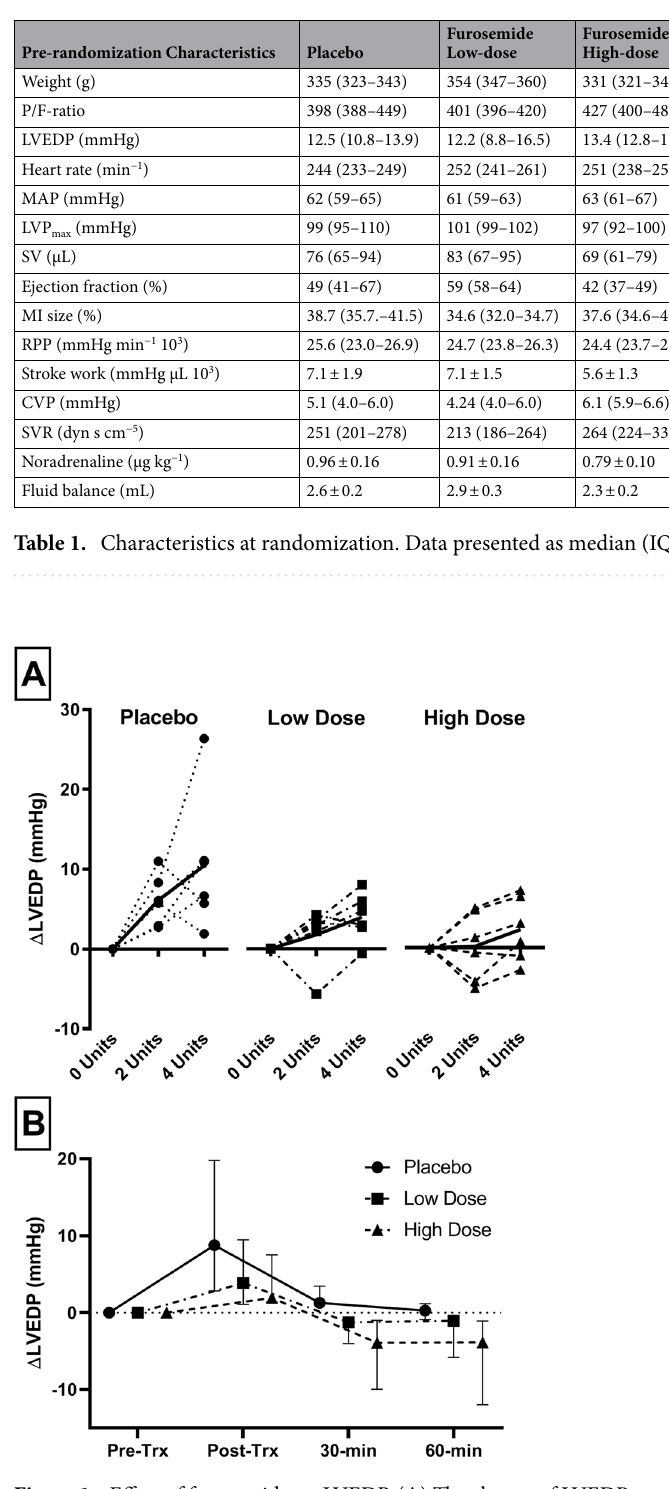
Figure 1. Effect of furosemide on LVEDP. ( A ) The change of LVEDP over the course of the transfusion is given per animal. Animals receiving the placebo group show the greatest increase in ΔLVEDP compared to low and high-dose furosemide. The decrease in LVEDP is dose-dependent and is apparent within 15-min. ( B ) The change of LVEDP over the course of the experiment. Animals receiving placebo have a greater increase in LVEDP post-transfusion and this remains higher through-out the follow-up period. ΔLVEDP difference between LVEDP at timepoint compared to baseline, Trx